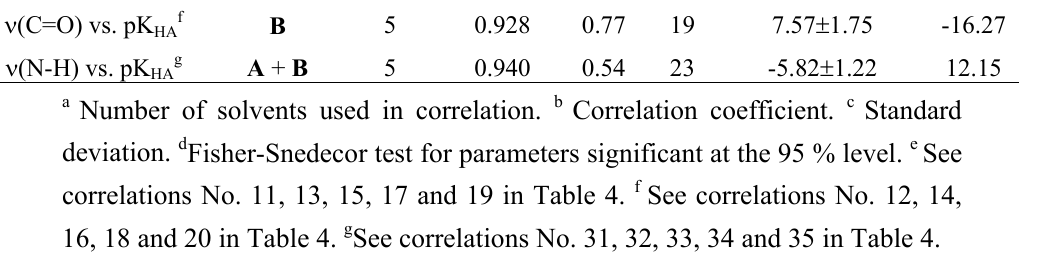
Table 5. Correlation between the slopes of dependencies of IR spectral wavenumbers vs. pK values in different solvents ( ρ ) and basicity HA of solvents (B * ) for the series 1 – 16 of substituted N -phenyl- sulfonylbenzamides. ρ = aB * + b Dependence Series